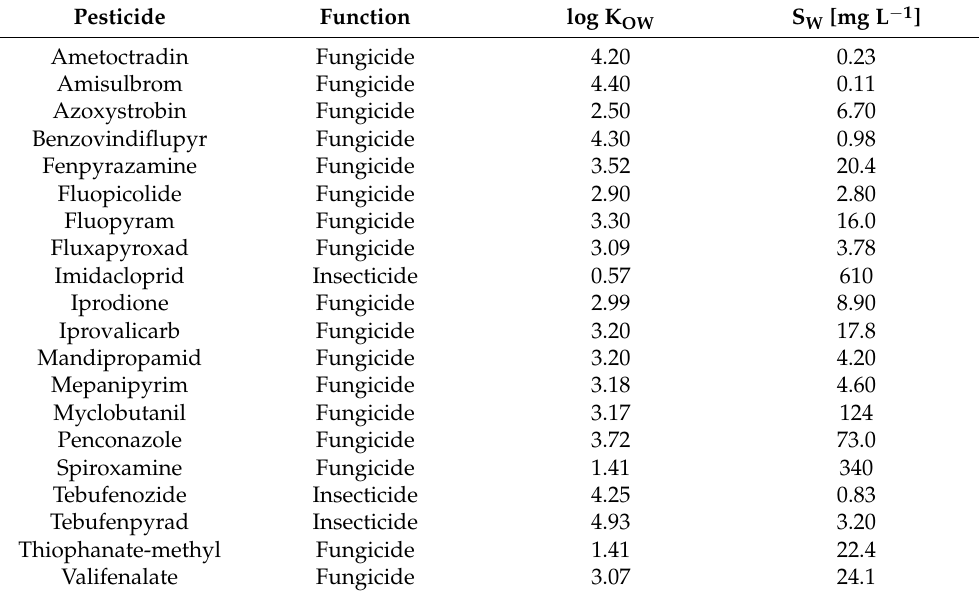
Table 1. Logarithm of the octanol-water partition coefficient (log K OW ) and water solubility (S W , at 20 ◦ C) of the investigated